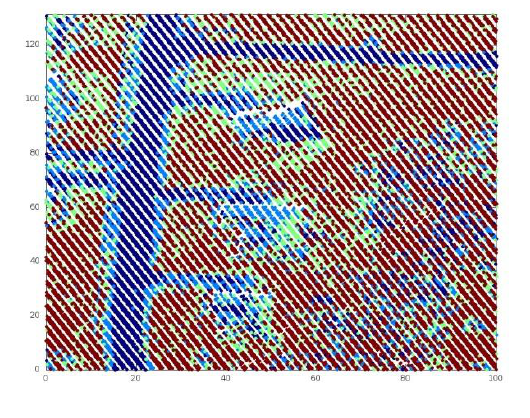
Figure 4: Penetration parameter in the test area The classification based only on the three parameters has difficulty in separating roofs and pavement. The source of the problem is likely the different surface normals for roofs. The second additional parameter describes the residuals of the Gaussian fitting. The standard deviation of the fitting error is typical for the selected four main classes, see Figure